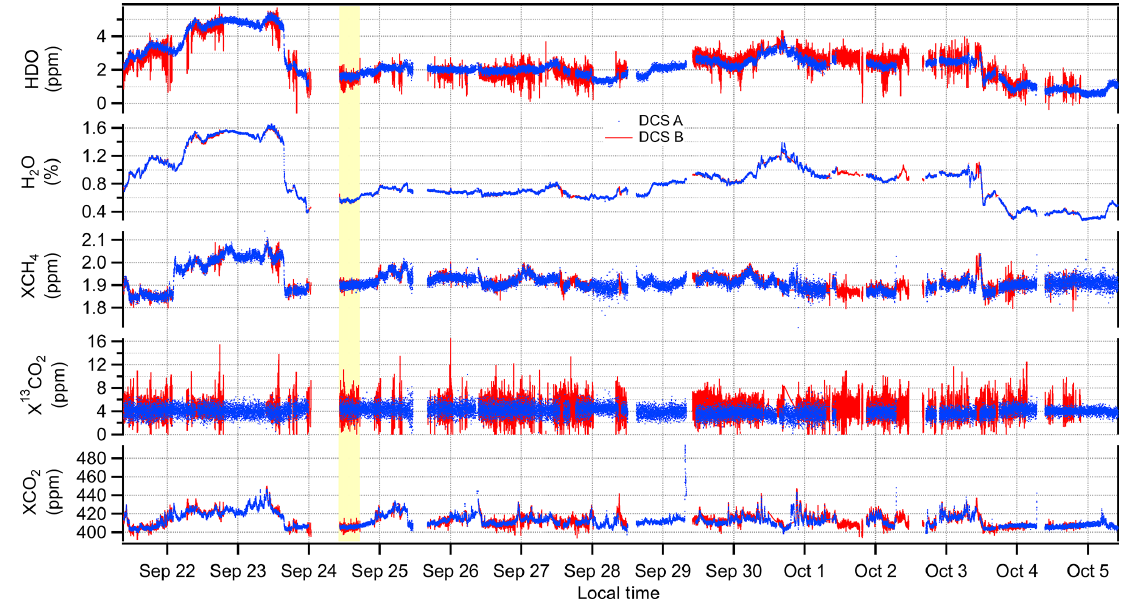
Figure 5. Concentration retrievals from DCS A (blue dots) and DCS B (red lines) for HDO (ppm), H 2 O (%), dry CH 4 , dry CO 2 , and dry 13 CO 2 over 2 weeks at 30s intervals. Excellent agreement is observed between both systems for all species, though it is clear that over this path length 13 CO 2 does not provide a strong enough signal to retrieve reliably. Highlighted section: 6h, well-mixed period over which Allan deviations (Fig. 8) are calculated. Missing data are primarily due to telescope misalignment and, less frequently, loss of phase lock by one of the